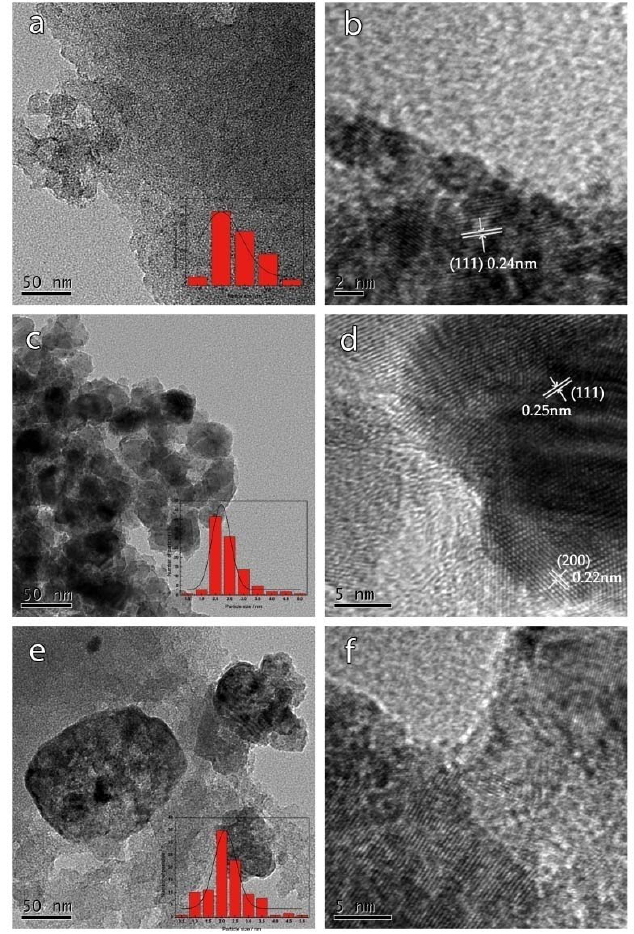
Figure 5. Representative TEM figures of ( a , b ) Mo 2 N/AC; ( c , d ) TiN/AC and ( e , f ) Mo 3 Ti 1 N/AC, respectively. Table 3. The binding energy and relative content of Mo, Ti and N species in the catalysts.